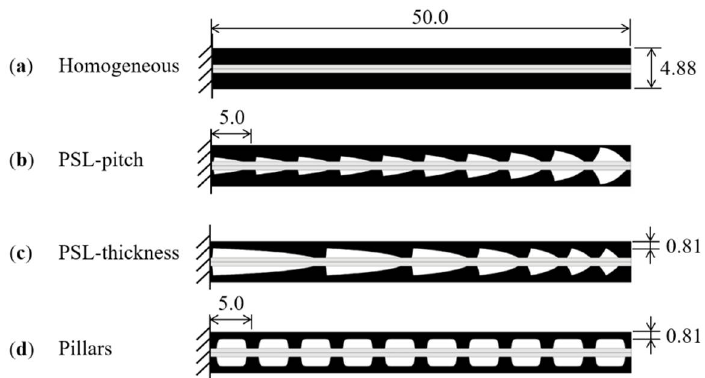
Figure 6. Models compared in FEM study. ( a ) Homogeneous material (Homogeneous). ( b ) Principal-stress-line (PSL)-based design with uniform pitch (PSL-pitch). ( c ) PSL-based design with uniform bottom thickness (PSL-thickness). ( d ) Beam using uniform pitch pillars (Pillars).